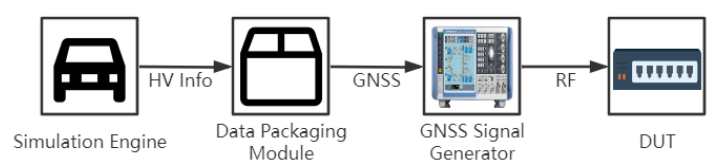
Figure 6. GNSS simulation hardware connection schematic.